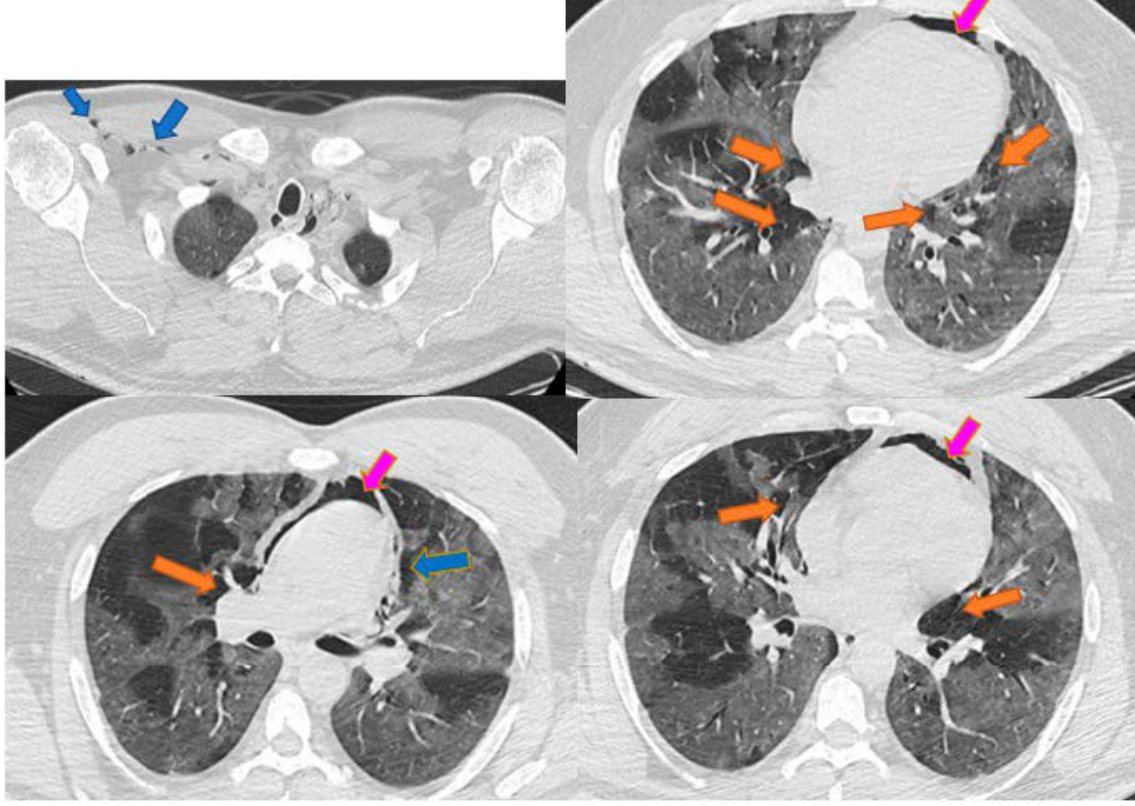
Figure 3. Case 3: Pneumomediastinum, pneumopericardium, and subcutaneous emphysema. Legend: PM— pneumomediastinum—orange arrow; PP—pneumopericardium—magenta arrow; SE—subcutaneous emphysema—blue